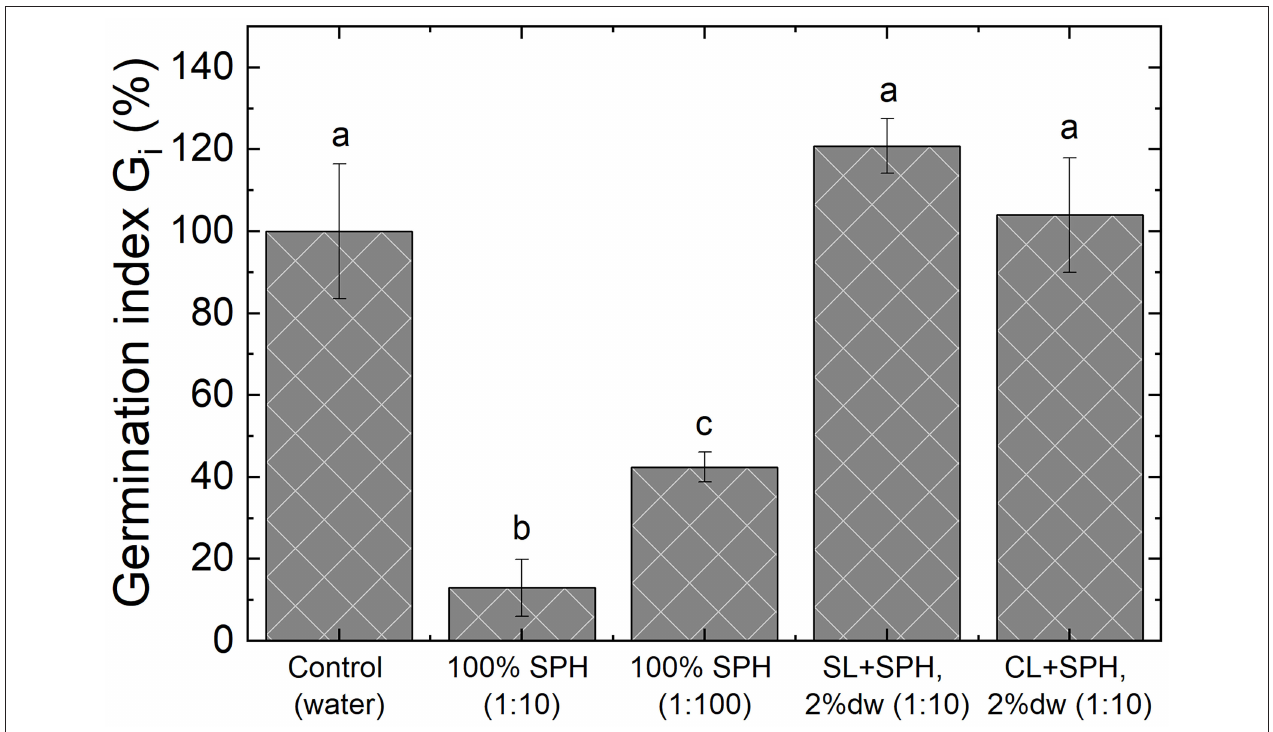
FIGURE 3 | Phytotoxicity of water extracts of spent pollinator hulls (SPH) for different concentrations (1:10 and 1:100) and the control (water) compared to 2% dw spent pollinator hulls in sandy loam (SL + SPH) and sandy clay loam (CL + SPH) at same concentrations (1:10) for radish seeds. Different letters indicate significant differences in a one-way ANOVA followed by a Tukey’s HSD post-hoc test. Bars represent standard deviations (10 seeds, n = 3).